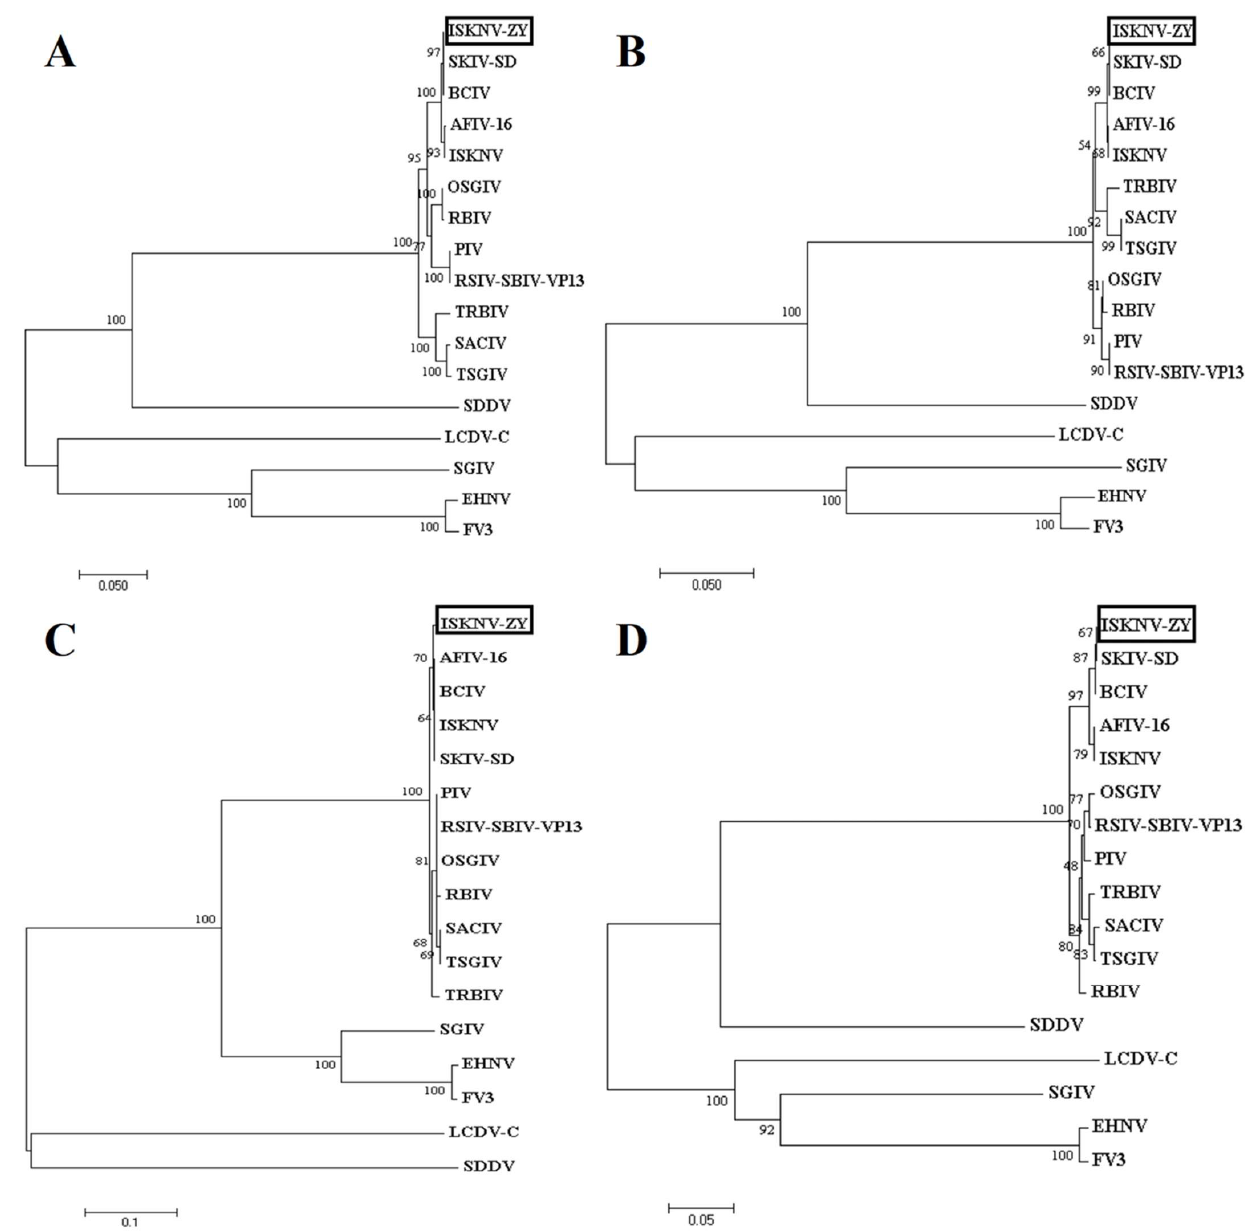
Figure 3. Phylogenetic relationship of infectious spleen and kidney necrosis virus (ISKNV)-ZY to other fish iridoviruses. Phylogenetic trees based on the amino acid sequences of DNA polymerase ( A ), Megalocytivirus major capsid protein (MCP) ( B ), ATPase ( C ), and ribonuclease III ( D ) were constructed using the MEGA software. All viral sequences are from the GenBank database (acces-